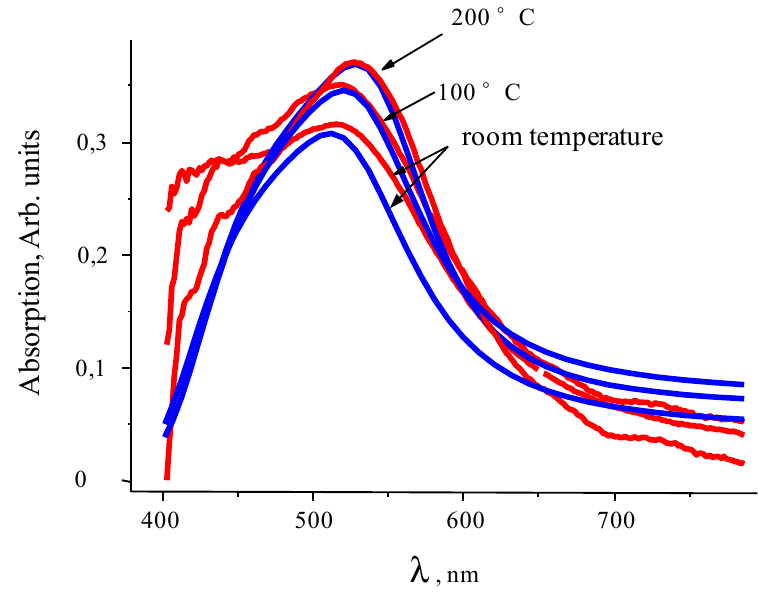
Figure 7. Extinction spectra of Au-PTFE film 2 during the annealing process. Blue lines correspond to modeling and red ones–to experiment.